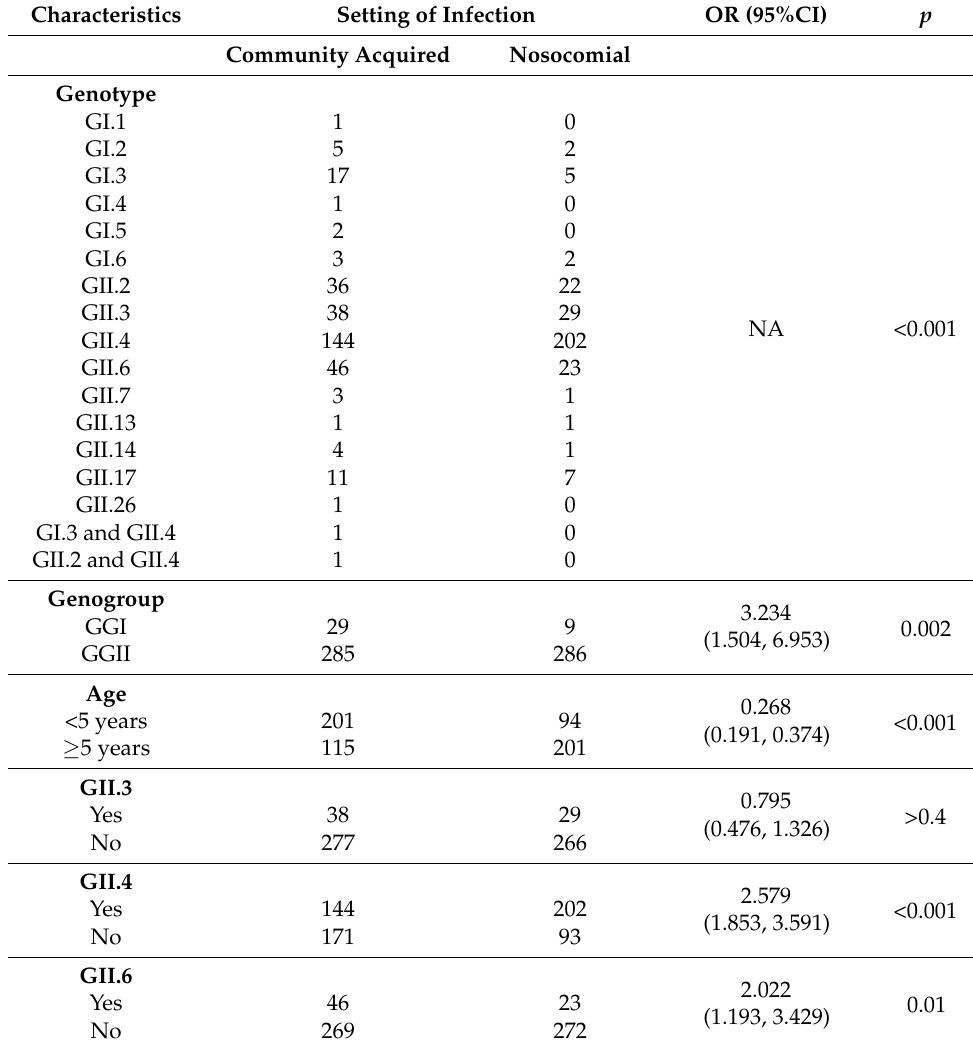
Table 2. Analysis of Characteristics of Norovirus-Positive